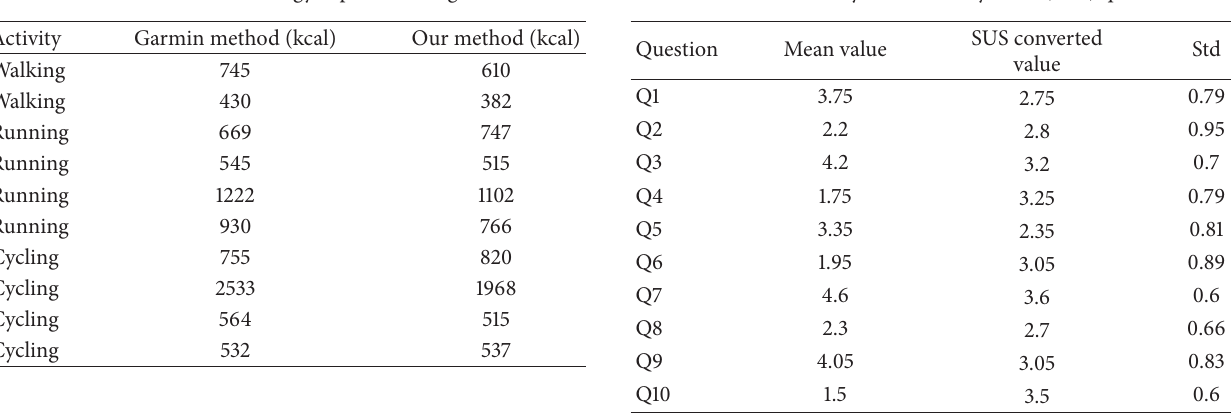
Table 5: Results of the energy expenditure algorithm.